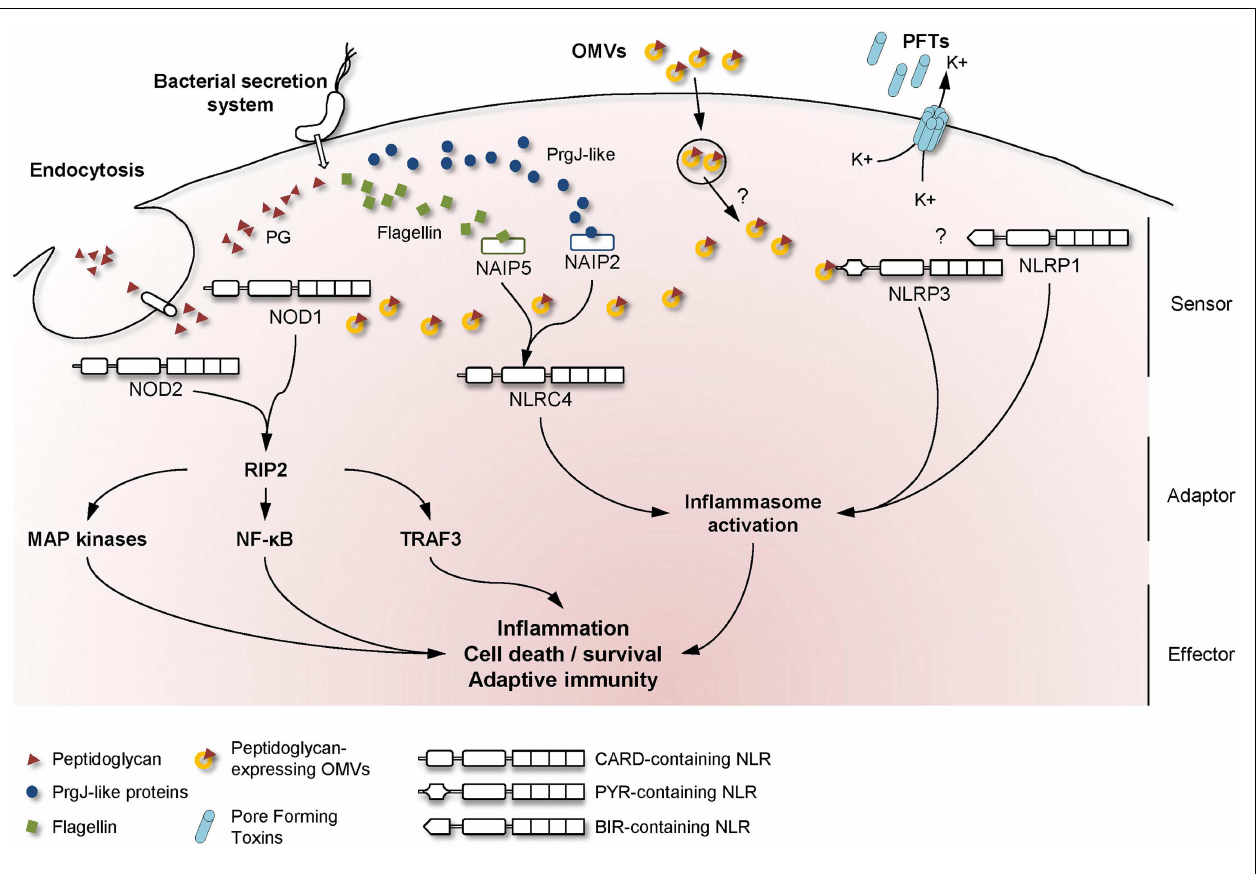
extracellular MAMPs are sensed by intracellular NLRs. Upon detection of the appropriate signal, NLRs are believed to oligomerize and recruit adaptor proteins to transduce the signal to downstream effector